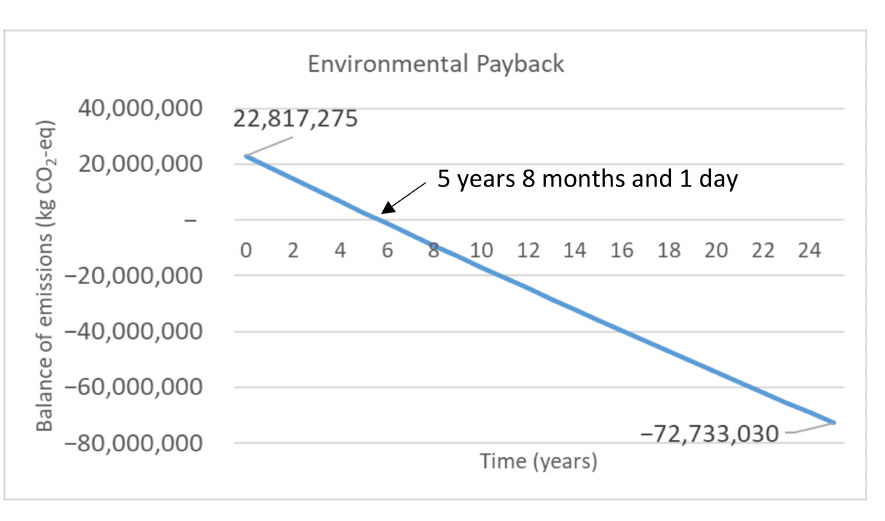
Figure 6. Environmental